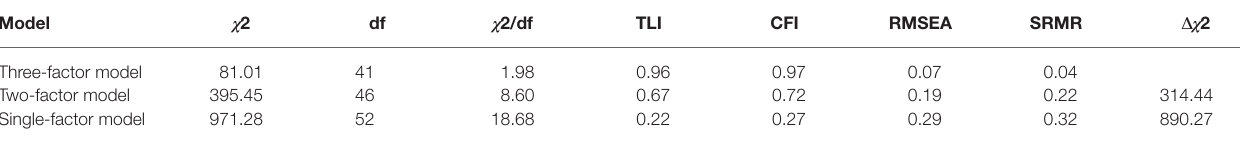
TABLE 1 | Model fit results for confirmatory factor analyses. Model